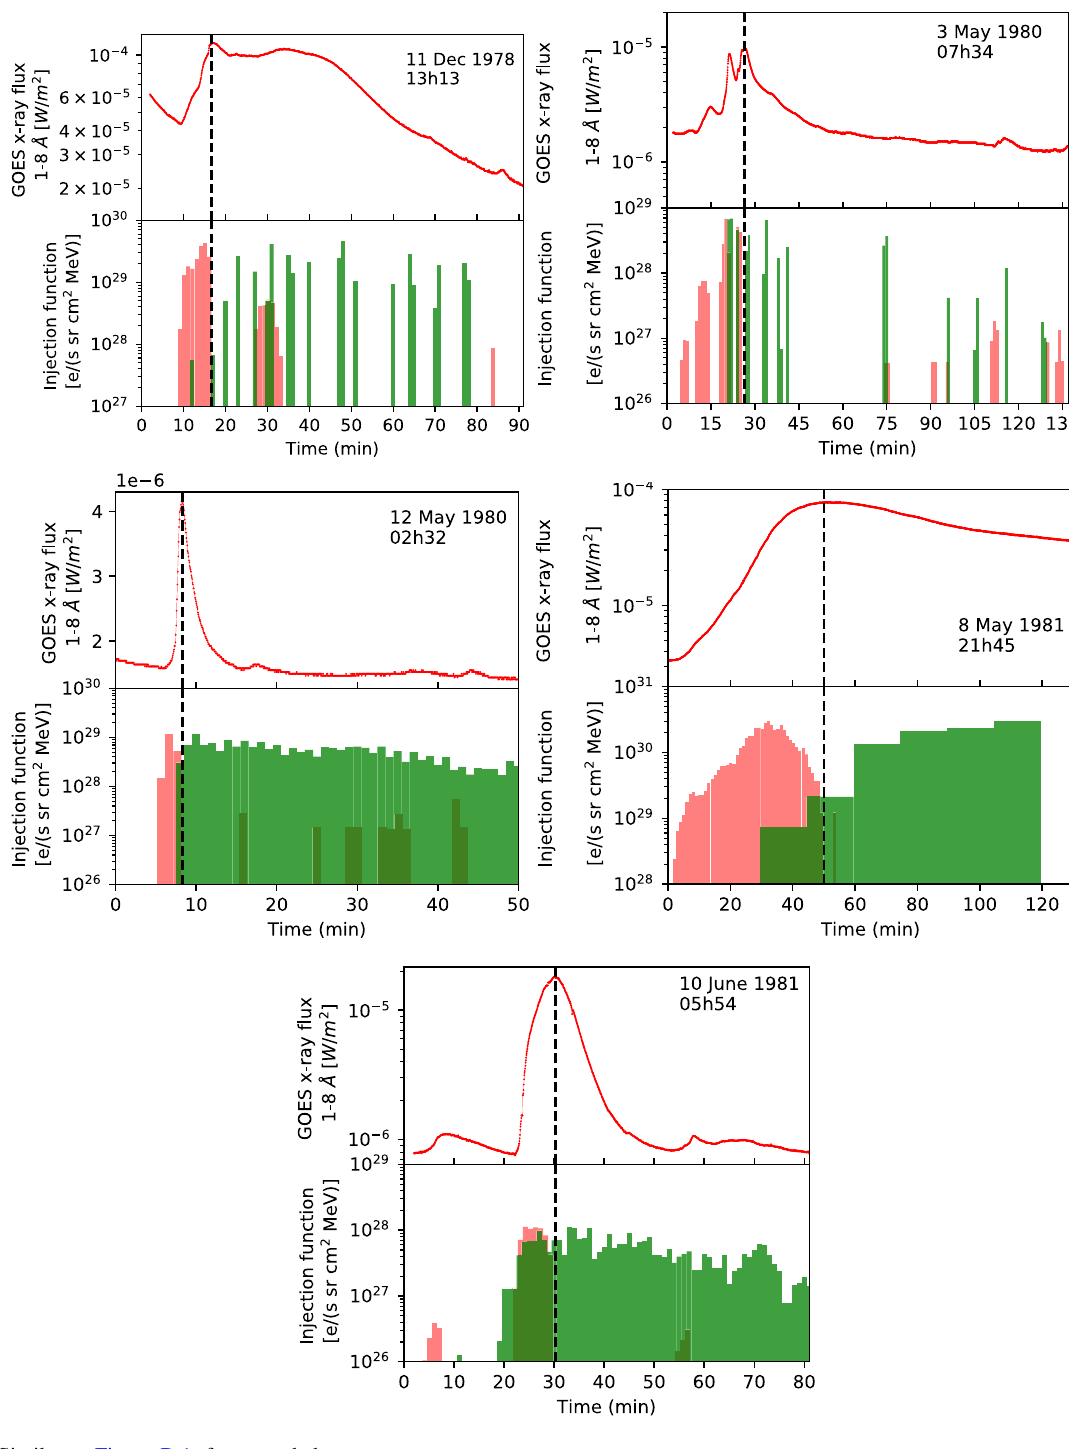
Fig. B.2. Similar to Figure B.1, for extended